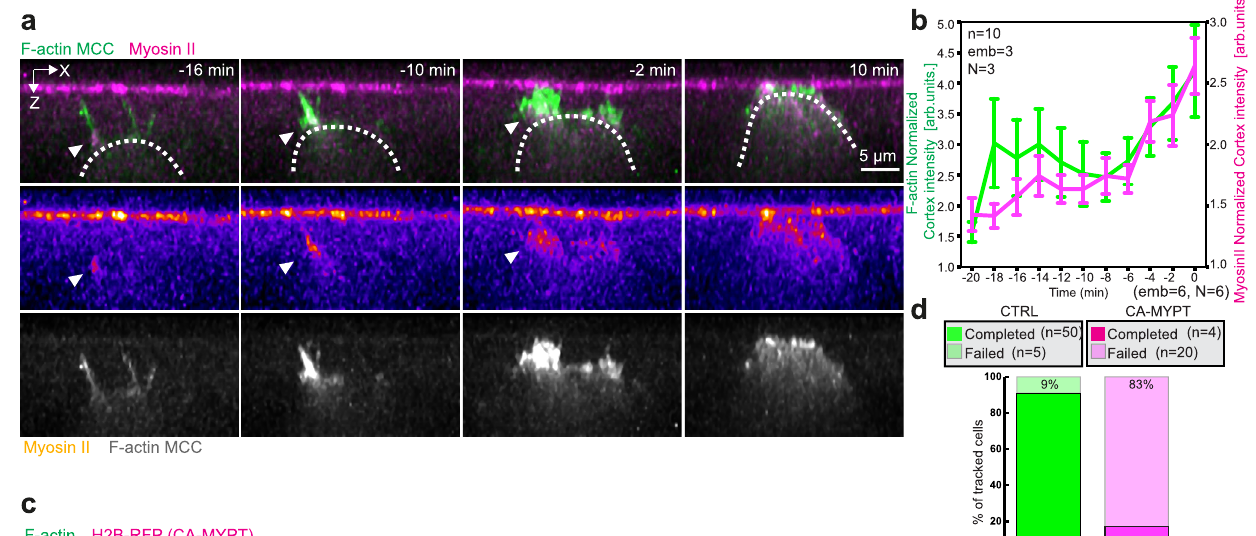
d Quanti fi cation of MCC integration success rates for control and CA-MYPT over- expressing cells (nWT=55 cells, nCA-MYPT=24 cells from 5 embryos, N =5 experiments). e Image sequence of a CAMYPT-overexpressing MCC attempting epithelial junction remodeling (orange arrowheads). Goblet cells and CA-MYPT overexpressing MCC express LifeAct-GFP mRNA (pseudo-colored in green). Scale bar: 5 μ m. f Junction length tracking for control (green) and CA-MYPT- overexpressing MCCs (magenta) (nWT=12 junctions, nCAMYPT=13 junctions from5embryos, N =5experiments).Boxplotsof fi naltoinitialjunctionlengthratio in control and CA-MYPT MCCs. The orange line indicates no overall junctional remodeling ( fi naltoinitial junction length ratio=1).Boxes extend from the 25th to 75th percentiles, with a line at the median and whiskers representing range within 1.5 interquartile range. Two-tailed Mann – Whitney test with 0.05 signi fi cance level * p =1.73E − 5.